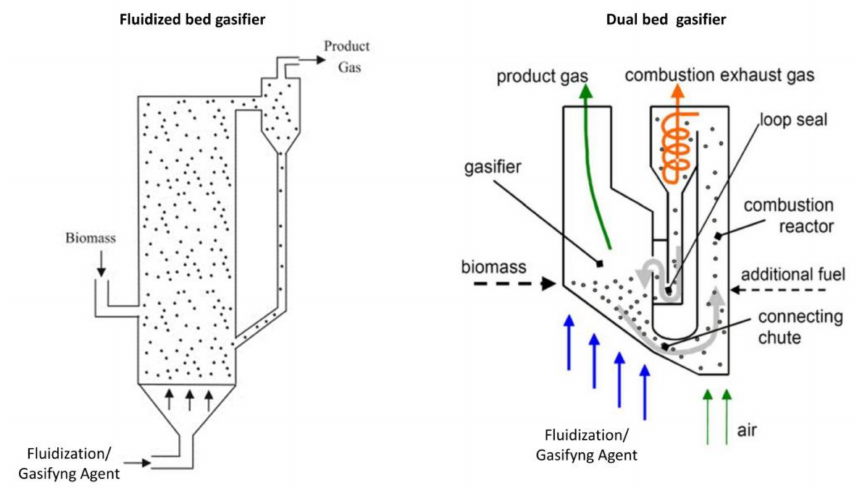
Figure 4. Fluidized bed gasifier schematization (adapted from Loha et al. [112]; Koppatz et al.